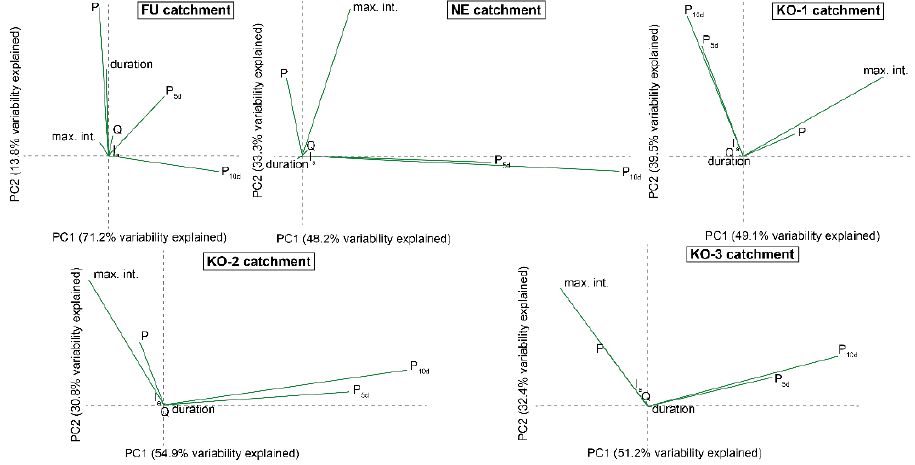
Figure 3. Principal component analysis PCA conducted for rainfall-runoff events in the experimental catchments.